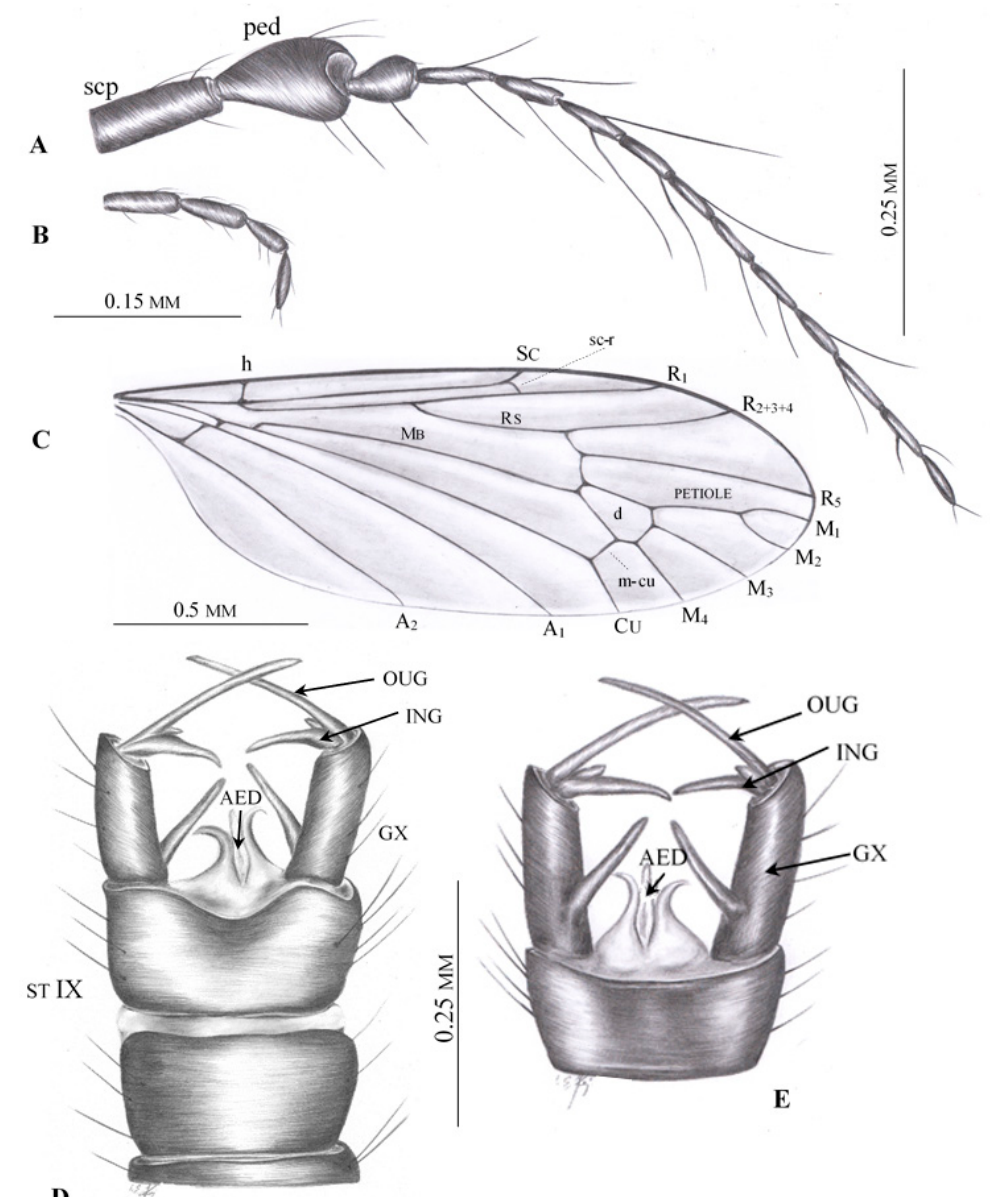
Figure 6. Decessia podenasi gen et sp. nov. No. MP/4067 holotype (male) (ISEA PAS). ( A ) antenna; ( B ) palpus; ( C ) wing venation; ( D ) hypopygium and last segments of abdomen, ventral view; ( E ) hypopygium, dorsal view. Abbreviation: scp —scape; ped—pedicel; aed—aedeagus; ing—inner gonostylus; oug—outer gonostylus; gx—gonocoxite; st IX—sternite IX.